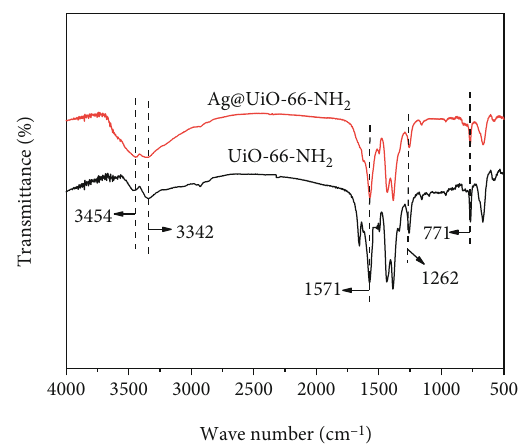
and Ag@UiO-66-NH 2